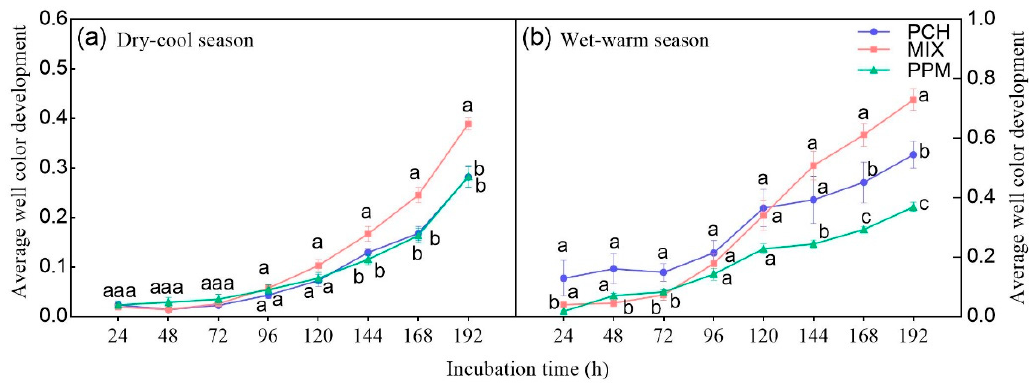
Figure 6. Soil microbial activity represented by average well color development (AWCD) in three plantations in the dry-cool season ( a ) and wet-warm season ( b ). Different letters above the bars denote significant differences at p < 0.05 level by LSD multiple comparisons among stand types ( n = 5).